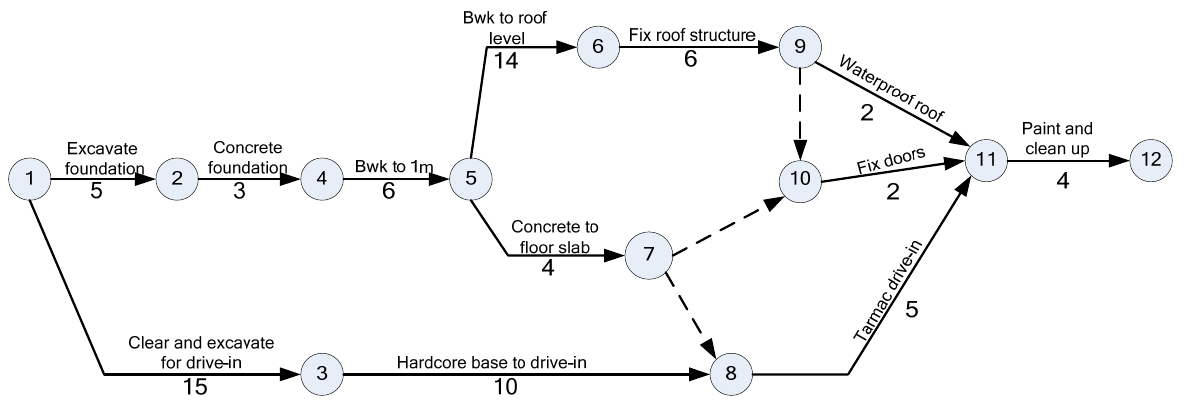
Figure 1. Arrow diagram of the case-study